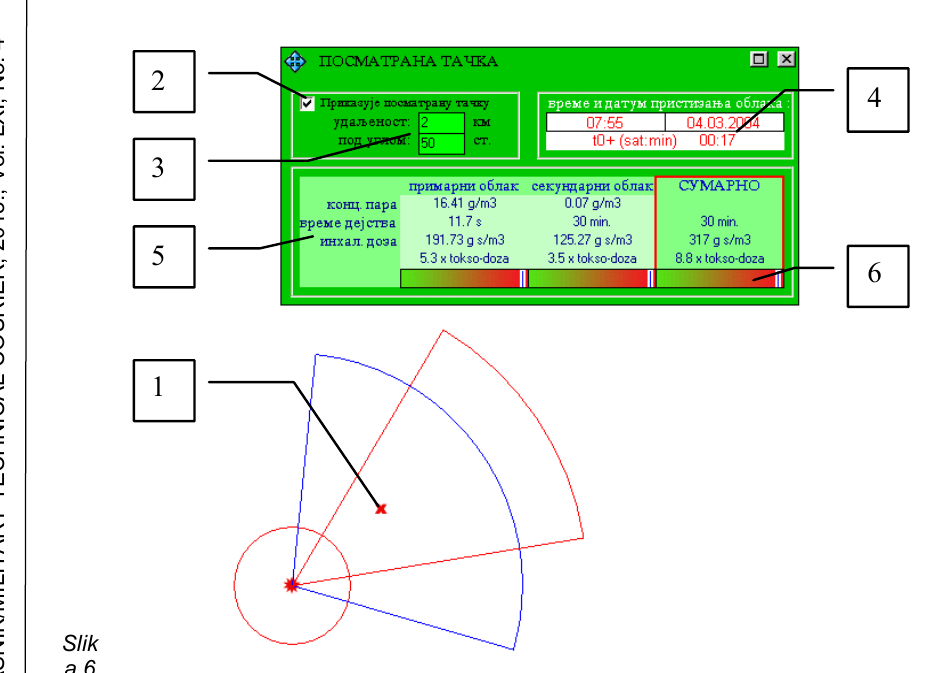
– Postavljanje i pra ć enje posmatrane ta č ke Figure 6 – Implementation and monitoring of the observed points Informacija o vremenu pristizanja oblaka do posmatrane ta č ke (4) data je u obliku datuma i vremena i u obliku vremena proteklog od udesa. Osnovne informacije o ugroženosti posmatrane ta č ke primarnim i sekundarnim oblakom, odnosno sumarno, mogu se videti na alatu kao informacije o koncentraciji para, vremenu dejstva i inhalacionoj dozi (5). Radi brzog i slikovitog uvida u ugroženost posmatrane ta č ke, na alatu je postavljen prostor u kojem se boja preliva od zelene (slaba ugroženost) do crvene (jaka ugroženost). Pozicioniranje linije na ovom prostoru odslikava ugroženost posmatrane ta č ke na odre đ enoj poziciji.